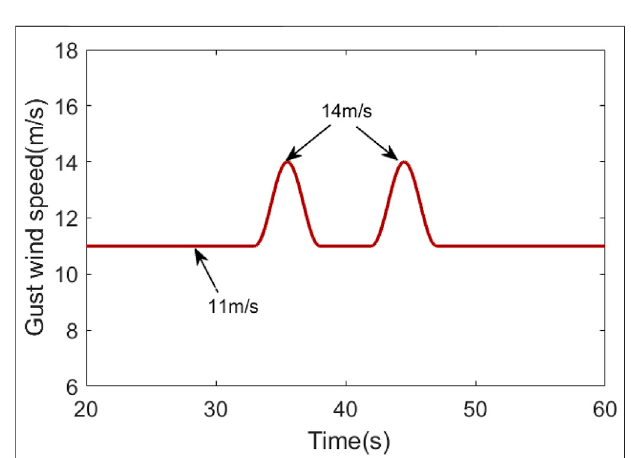
FIGURE 9 | Gust wind speed